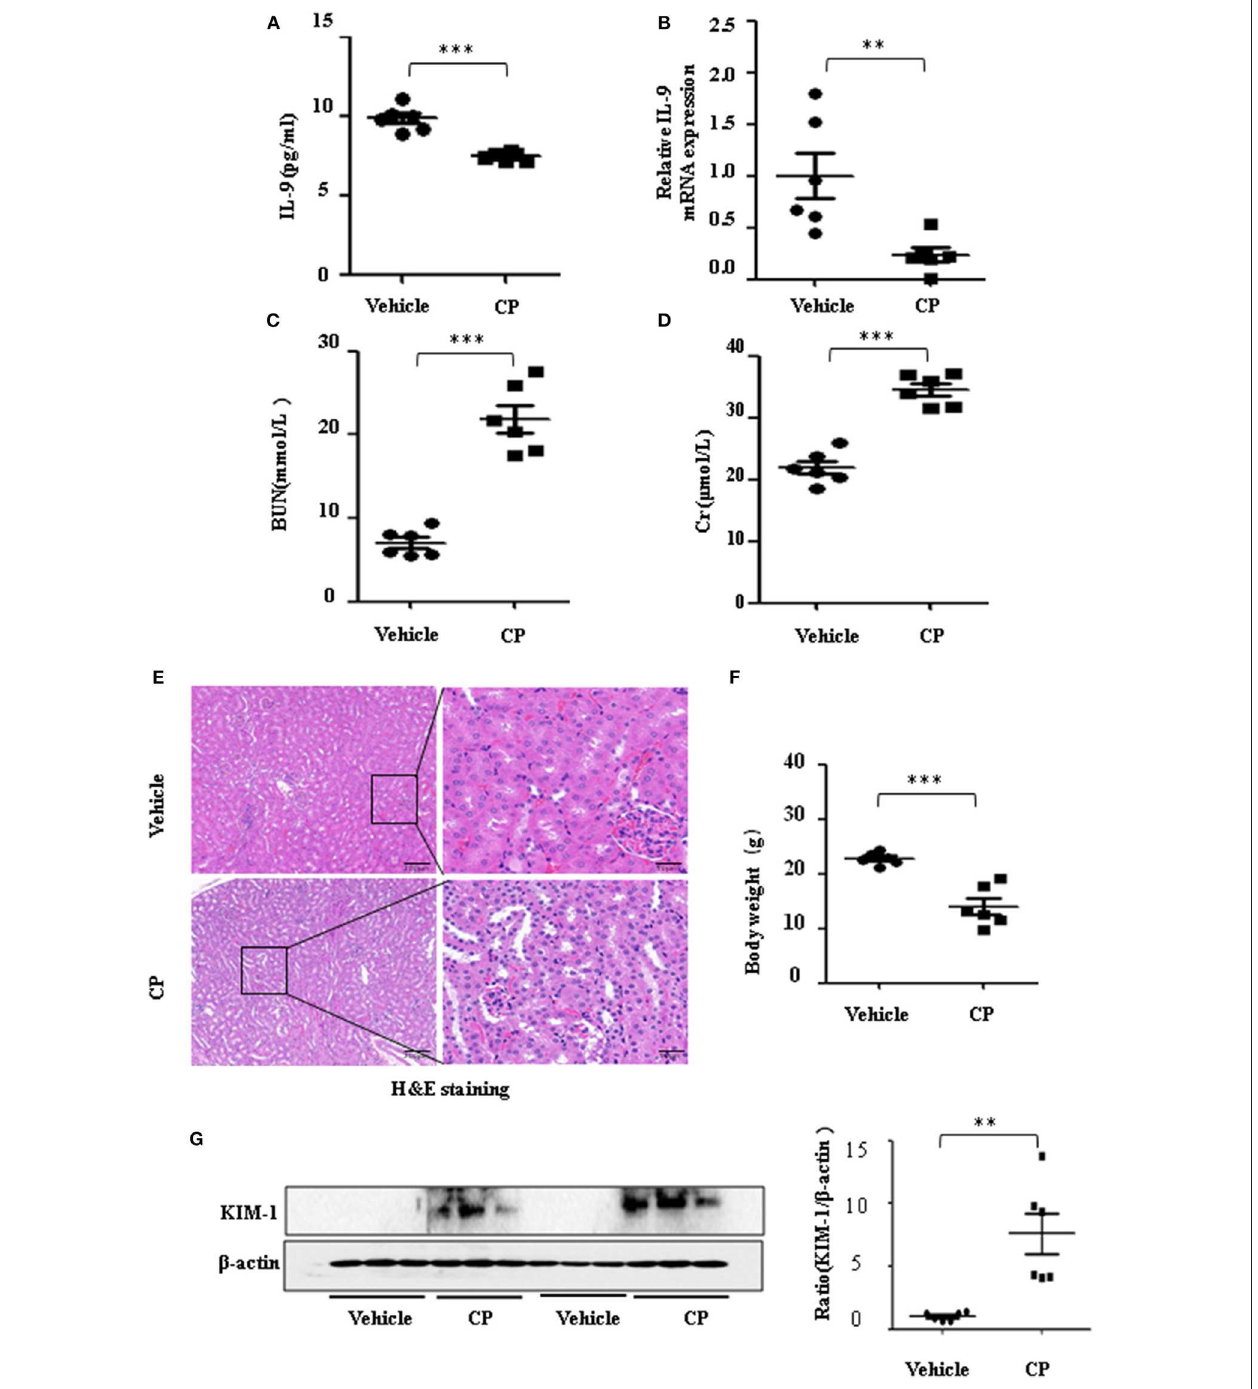
FIGURE 1 | The secretion of interleukin-9 (IL-9) was downregulated in the cisplatin (CP)-induced acute kidney injury (AKI) model. Mice were induced with a single intraperitoneal injection of either saline (vehicle) or CP (20 mg/kg body weight). Three independent experimental series were performed with six animals per group in each series. Data were represented as mean ± SD ( n = 6). (A) The level of IL-9 in the kidneys was assessed by ELISA. *** P < 0.001 vs. the vehicle group. (B) The mRNA level of IL-9 in the kidneys of CP-induced AKI. Dot plots showed the corresponding quantification of mRNA levels and fold change. ** P < 0.01 vs. the vehicle group. (C) Changes in blood urea nitrogen (BUN) level with CP-induced mice. *** P < 0.001 vs. the vehicle group. (D) Changes in serum creatinine (Cr) level with CP-induced mice. *** P < 0.001 vs. the vehicle group. (E) Representative images of H&E staining of the kidney section of CP-induced mice were analyzed under bright–field microscopy. Magnification: × 10 and × 40. (F) Body weight in each group after 72h of CP injection. *** P < 0.001 vs. the vehicle group. (G) Western blot was performed on the CP-induced kidney to determine the kidney injury molecule-1 (KIM-1) expressions. Each lane represents one sample from an individual mouse. Dot plots show the corresponding quantification of band intensity and fold change.